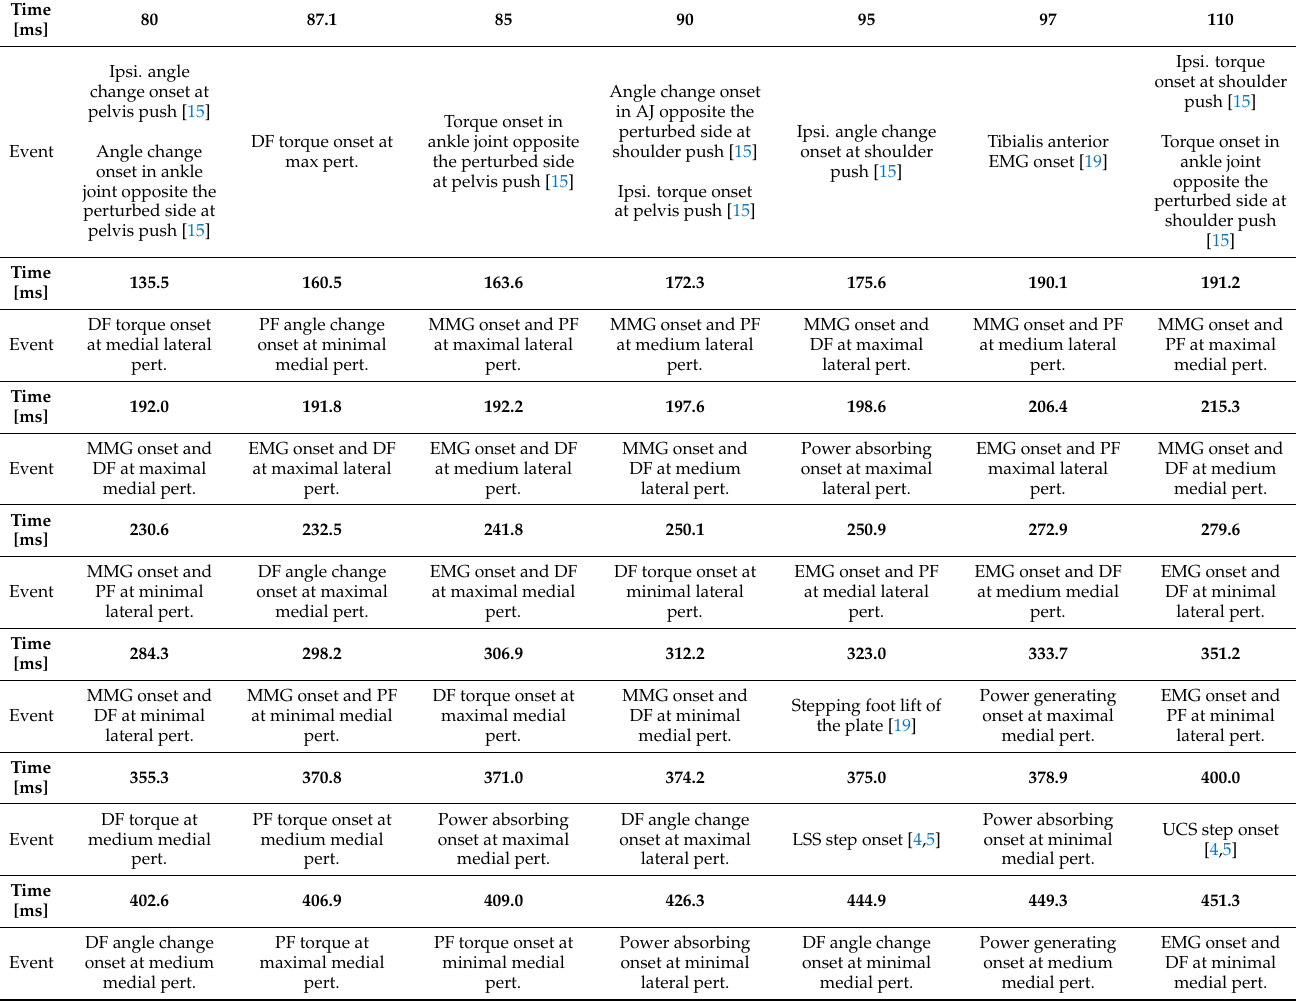
Table A1. A detailed description of the temporal reactions to mediolateral perturbations in the